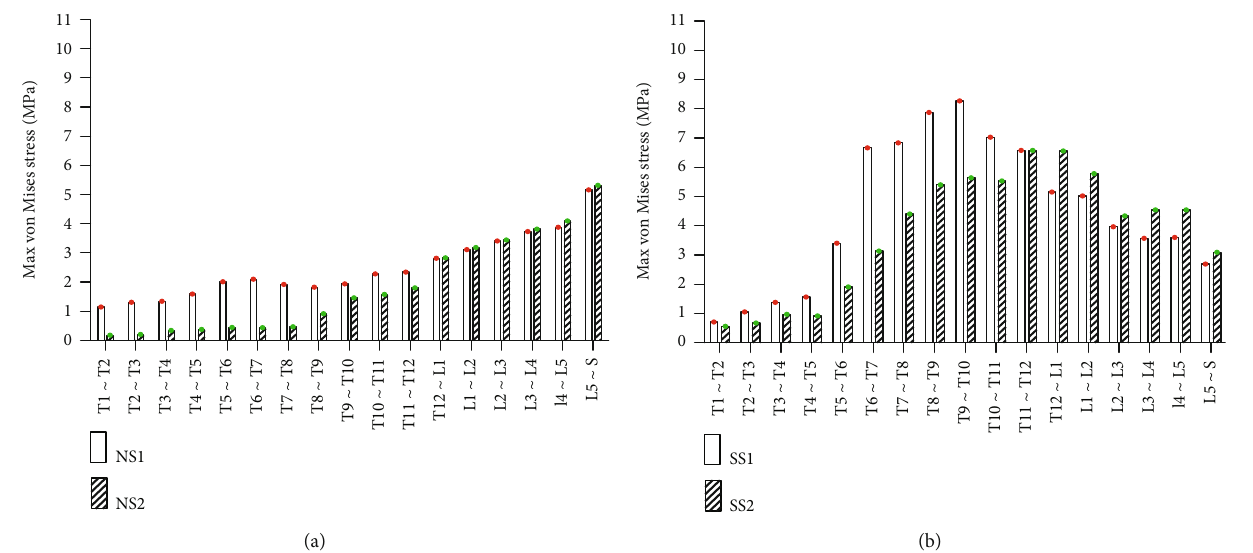
Figure 11: Stress distribution of disc in four spinal models with posterior supine: (a) stress distribution of normal spinal intervertebral discs; (b) stress distribution of scoliotic spinal intervertebral discs. NS1, NS2, SS1, and SS2 need to be de fi ned here.